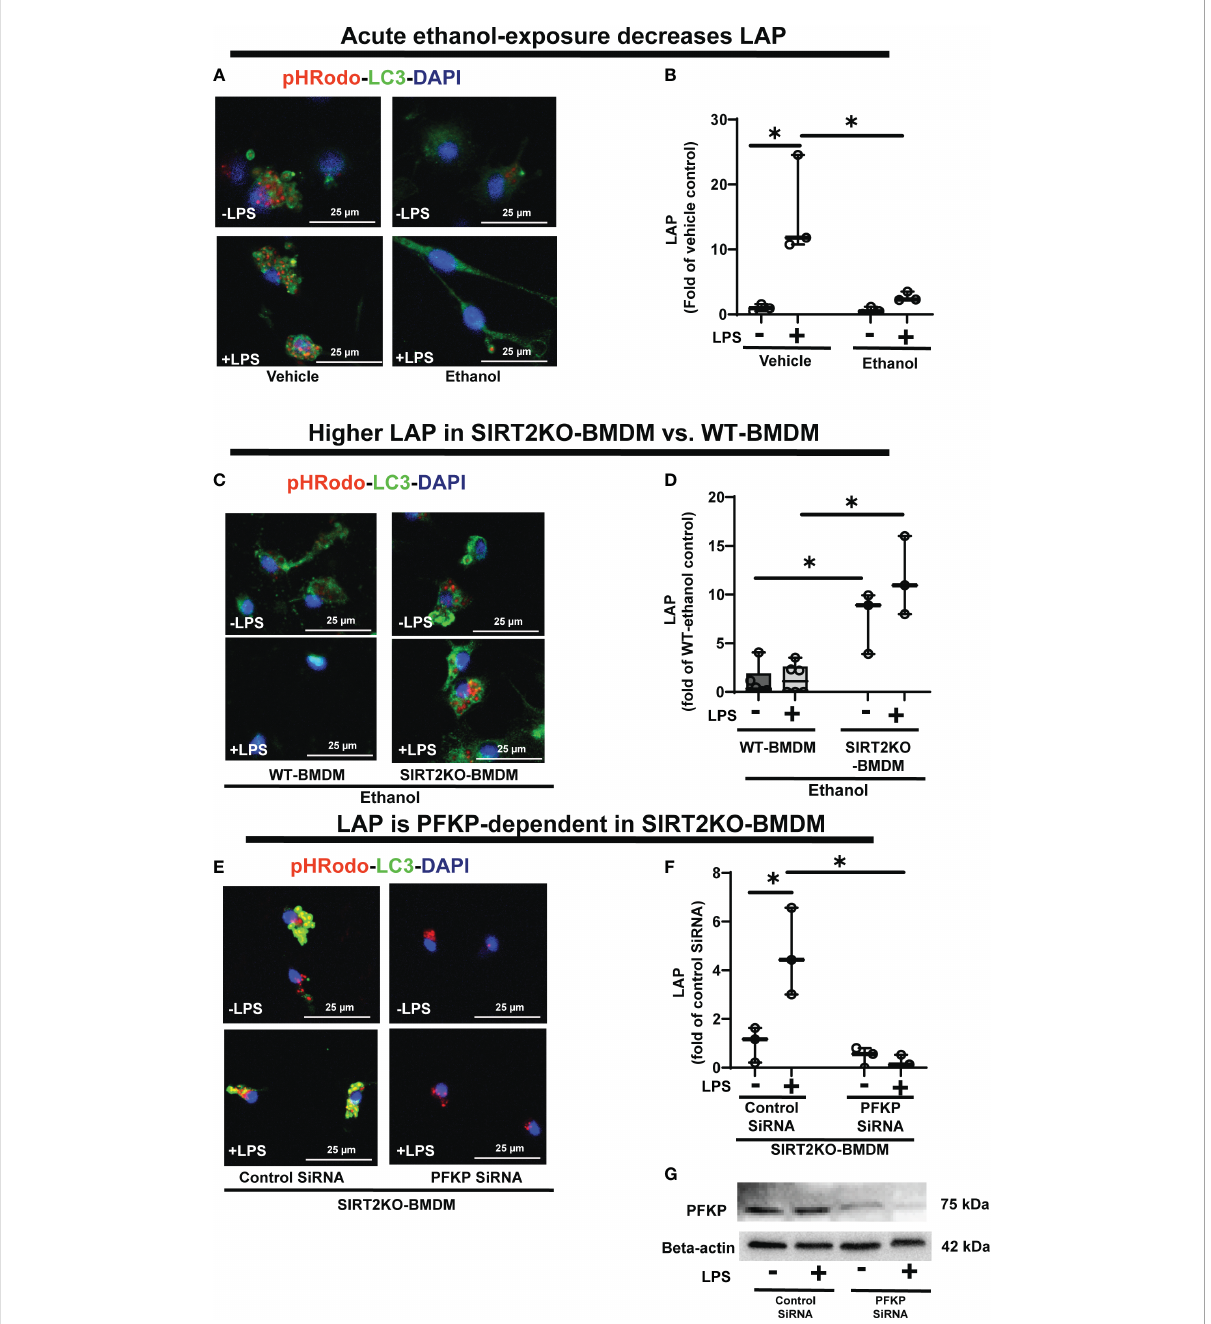
FIGURE 8 The effect of acute ethanol-exposure on LC3-associted phagocytosis in macrophages. LC3-associated phagocytosis (LAP) in WT-BMDM and SIRT2KO-BMDM, exposed to vehicle or ethanol ± LPS. (A) Representative images of intracellular pHrodo bioparticles during phagocytosis, co- stained for LC3. (B) For each image, the co-localization of intracellular pHrodo (red) and LC3 (green) were determined as LAP and divided by the total numbers of cells (nuclei). Graph represents fl uorescence quanti fi cation of LAP in WT-BMDM (n=4; * p<0.05). (C) Representative images of LAP in WT-BMDM and SIRT2KO-BMDM exposed to ethanol ± LPS. (D) Fluorescence quanti fi cation of LAP in WT-BMDM and SIRT2KO-BMDM (n=5; * p<0.05). (E) Representative images of LAP in either control siRNA or PFKP siRNA nucleo-transfected SIRT2KO-BMDM. (F) Fluorescence quanti fi cation of LAP in siRNA nucleo-transfected SIRT2KO-BMDM (n=4; * p<0.05). (G) PFKP expression was analyzed in either control siRNA or PFKP siRNA nucleo-transfected SIRT2KO-BMDM ± LPS. PFKP protein expression was detected by western blot in whole cell